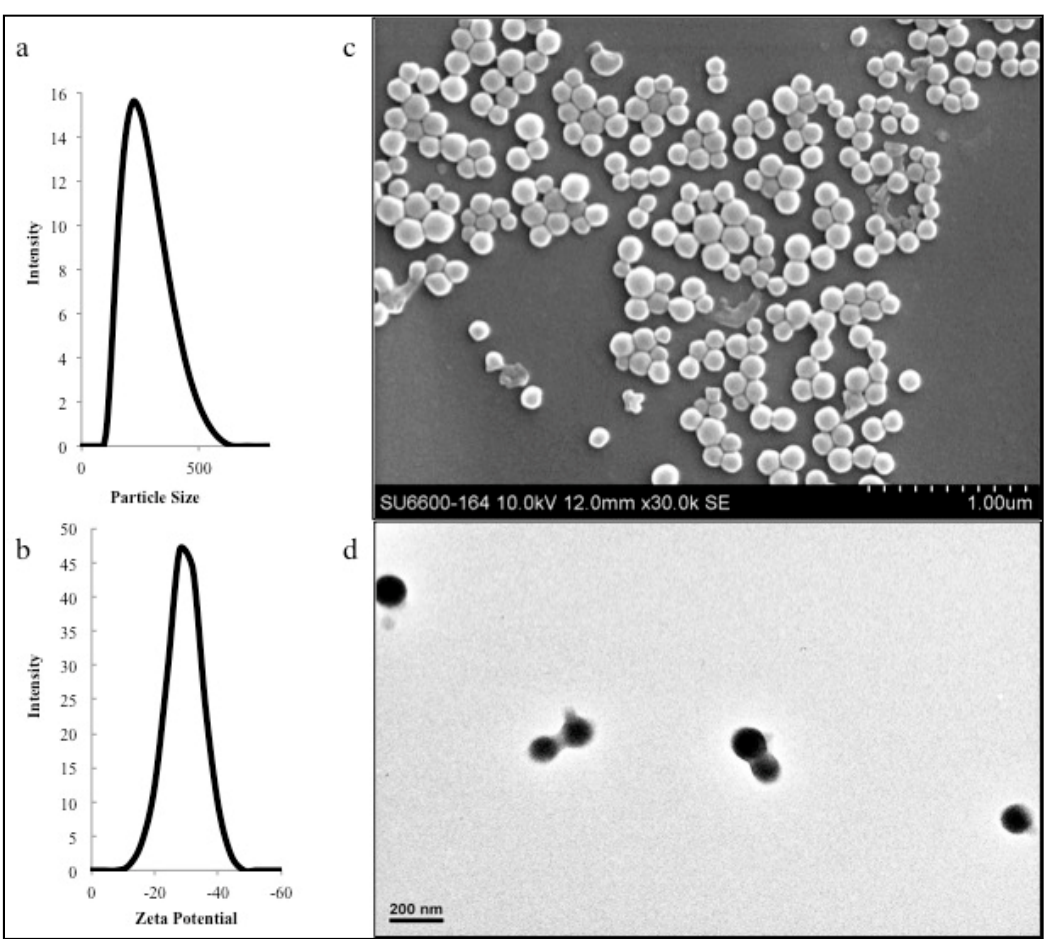
Figure 2. ( a , b ) Particle size distribution between 78 to 500 nm and zeta-potential distribution of − 11.8 to − 48.1 mV. The average particle size (obtained from DLS) was found to be around 222 nm and average zeta potential as around − 30 mV; ( c , d ) SEM and TEM images of the synthesized DNPs, respectively. SEM images shows particle various sizes around ~200 nm. TEM images confirms small particle size ~100 to 150 nm. The DNP images from SEM and TEM confirmed the observation from DLS.